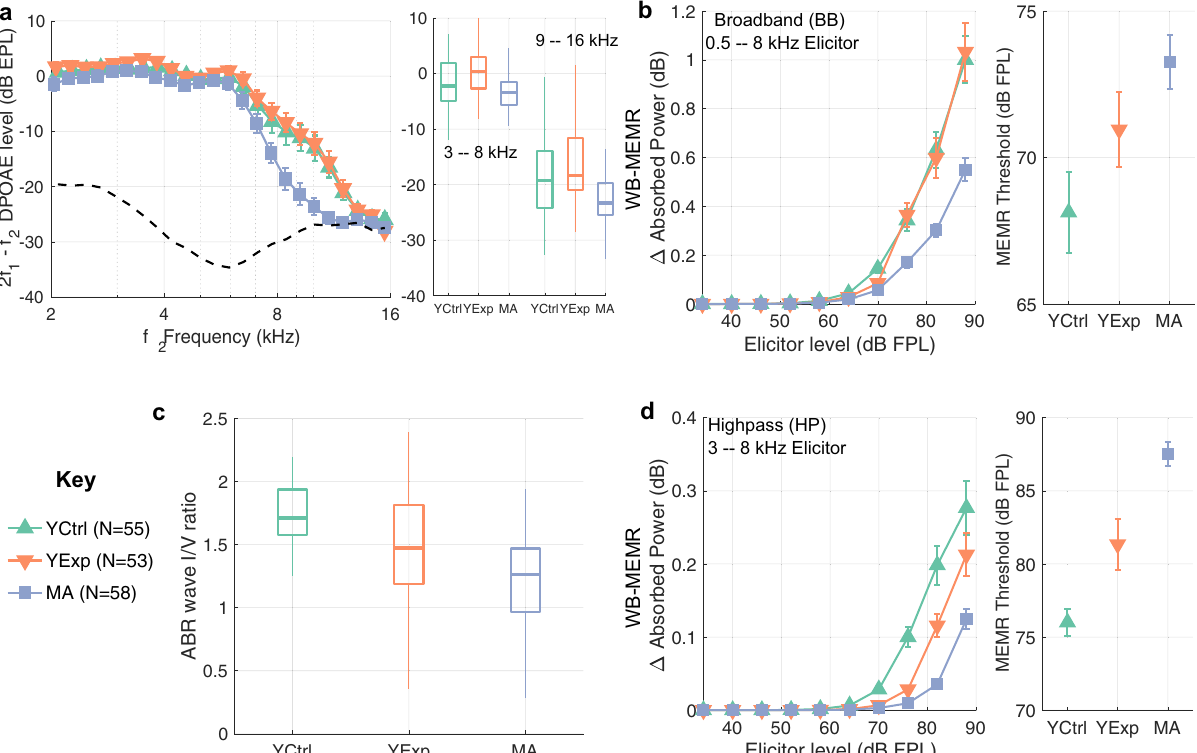
Fig. 2 YExp and MA human groups show reduced WB-MEMR and ABR compared to YCtrl despite tightly matched audiograms. a DPOAE amplitudes are closely matched up to 8 kHz. The MA group shows reduced DPOAEs between 8 to 16 kHz, consistent with audiograms. Box plots of DPOAE amplitudes averaged over two frequency ranges (3 – 8 kHz, and 9 – 16 kHz) are shown on the right side of ( a ) to visualize the full distribution of the data. b , d WB-MEMR to BB elicitors is signi fi cantly reduced in the MA group ( b ), whereas both high-risk groups show reductions with HP elicitors ( d ). WB- MEMR datapoints are estimated mean ± STE bars. Box plots to visualize the full distribution of the WB-MEMR data for the higher elicitor levels can be found in Supplementary Fig. 8. c ABR wave-I/V ratio is reduced in both high-risk groups. All box plots show the median line enclosed in a box denoting the 25th to 75th percentile range, and whiskers of length 1.5 times the interquartile range. Underlying data are archived on Zenodo (https://doi.org/10.5281/ zenodo.6672827) 61